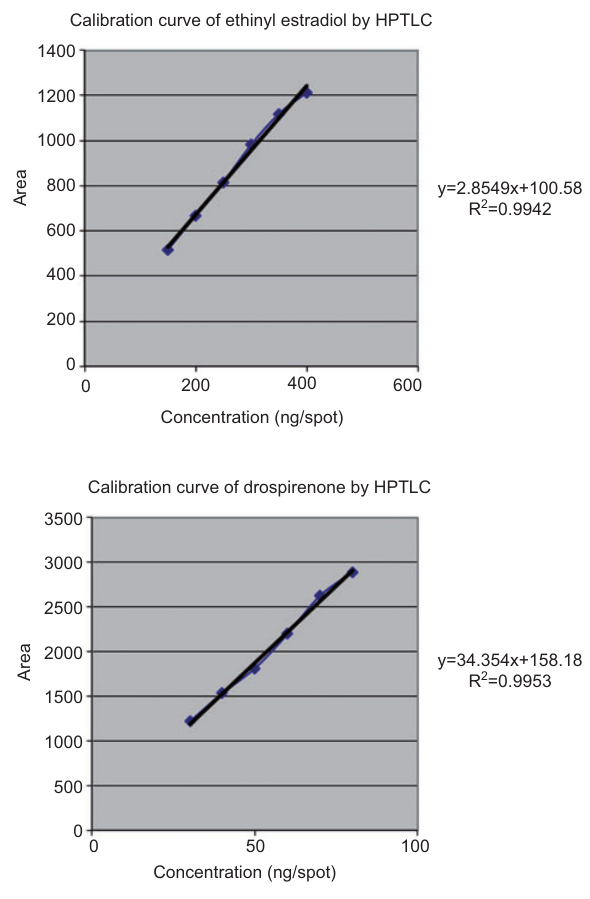
Figure 4 Linearity